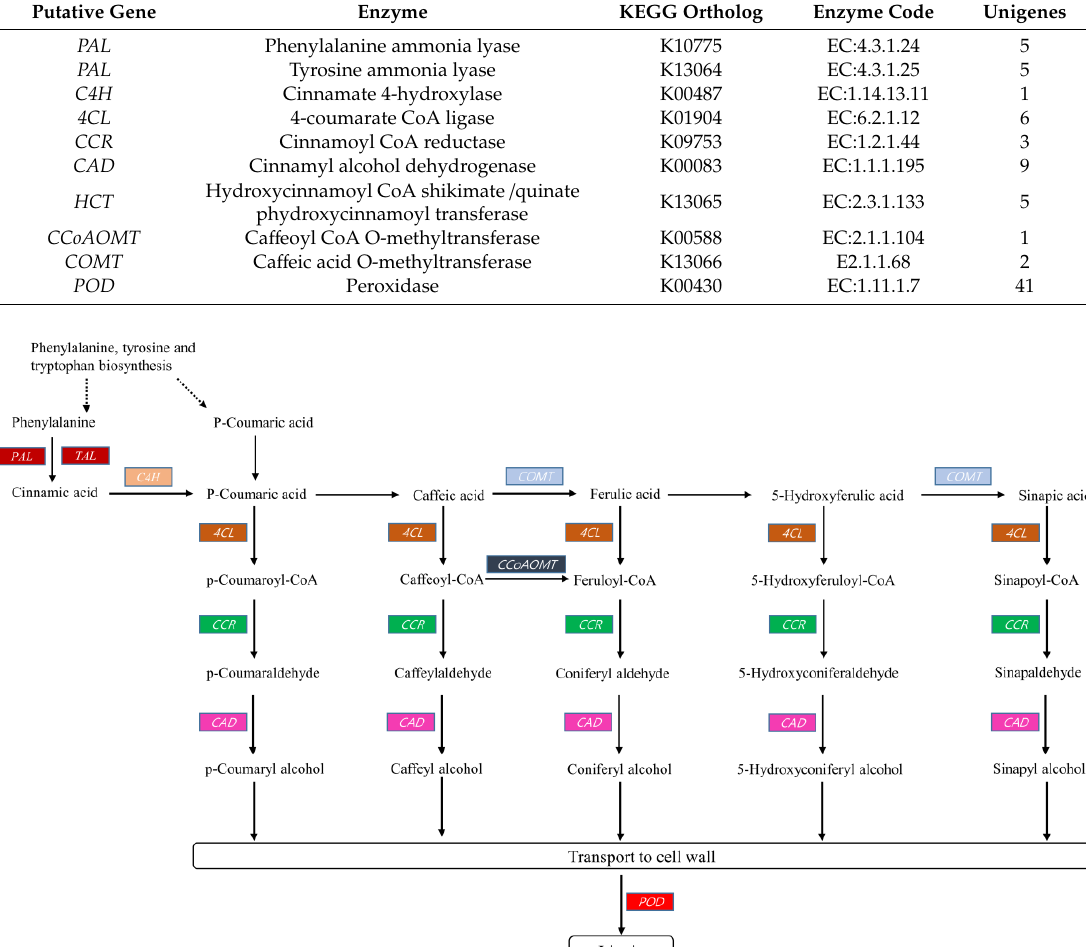
Figure 6. Hypothetical pathway constructed with kenaf unigenes (highlighted) involved in lignin